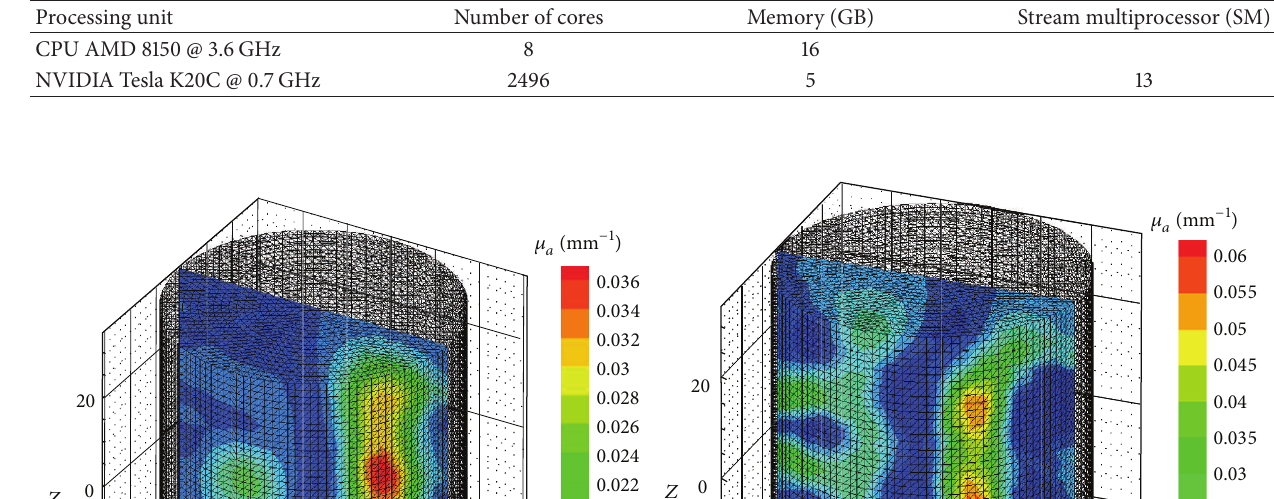
Table 1: Test systems.